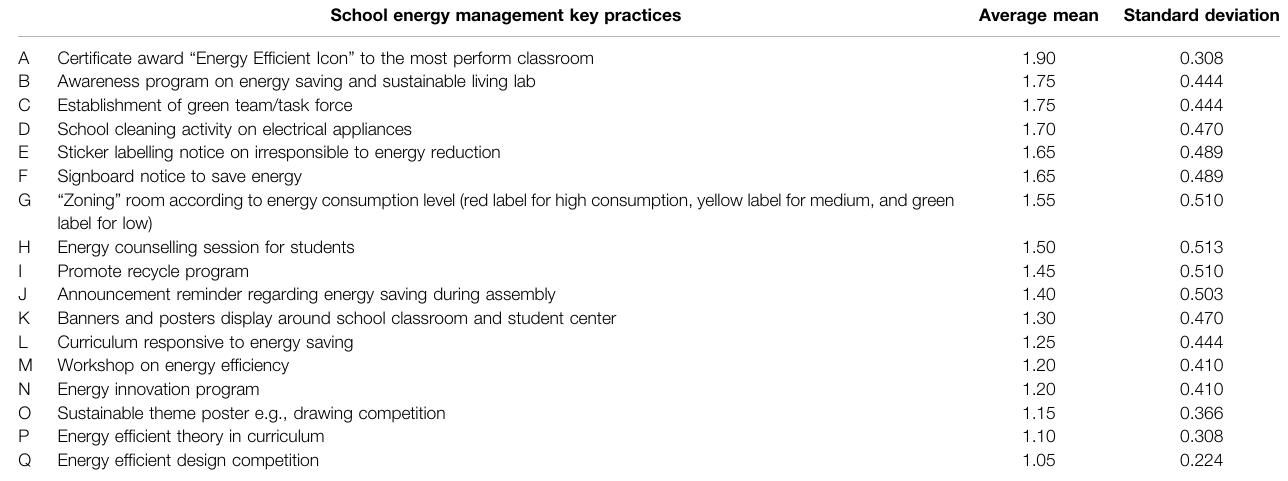
TABLE 1 | List of actions implemented by the school